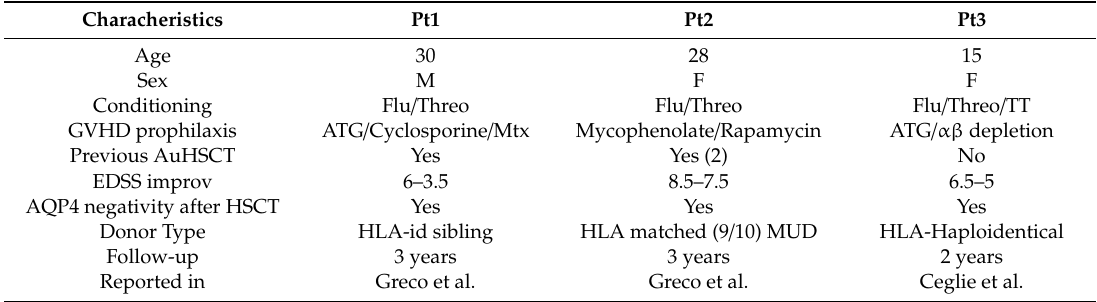
Table 1. Summary of patients’ characteristics of reported allogeneic hematopoietic stem cells